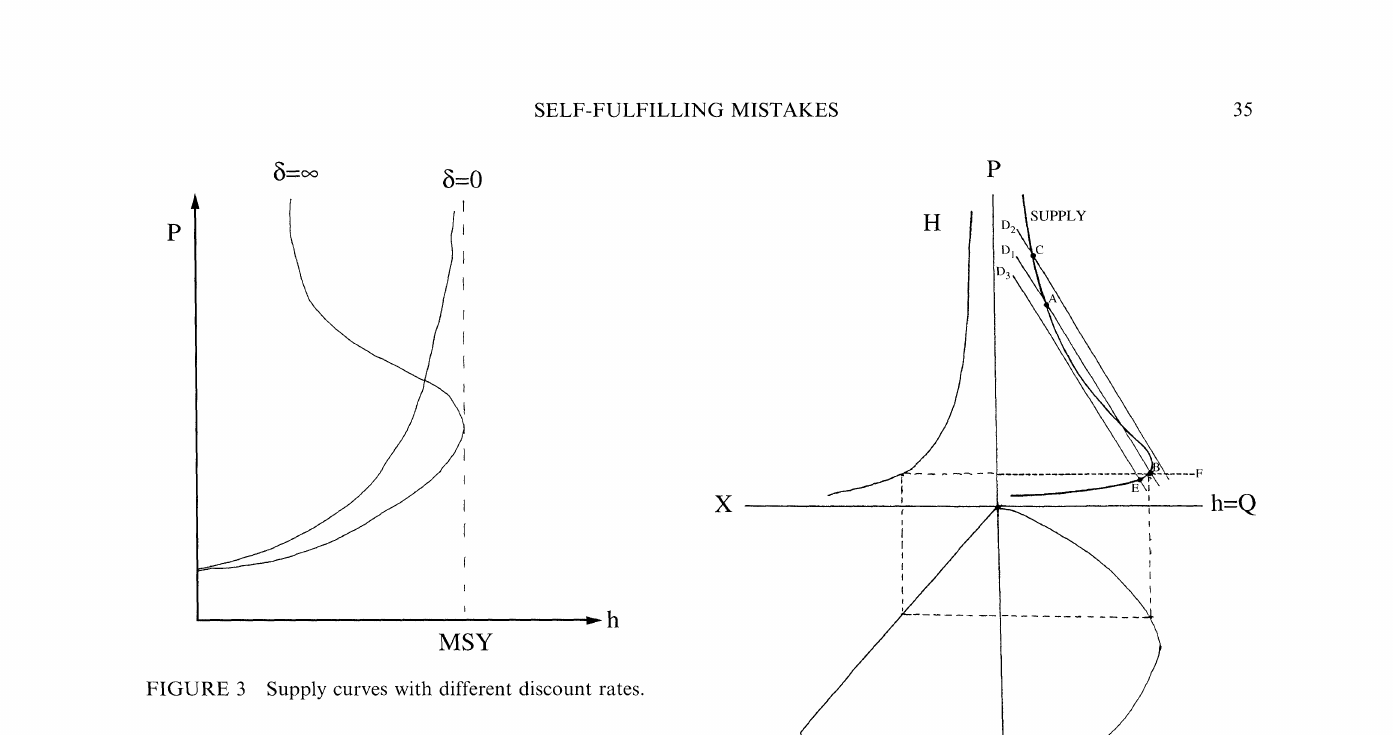
FIGURE 3 Supply curves with different discount rates.